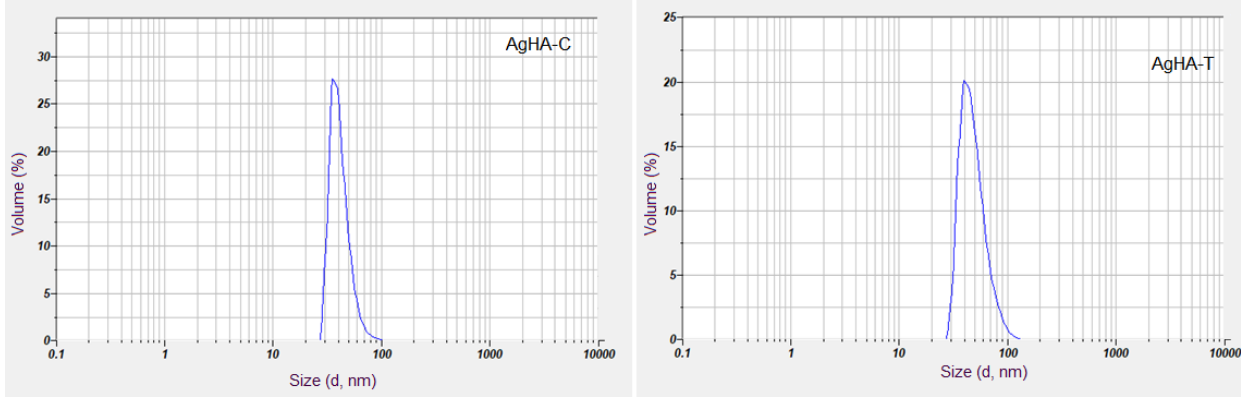
Figure 1. The volume size distribution analyzed with DLS for AgHA-C ( left ) and AgHA-T ( right ) suspensions.